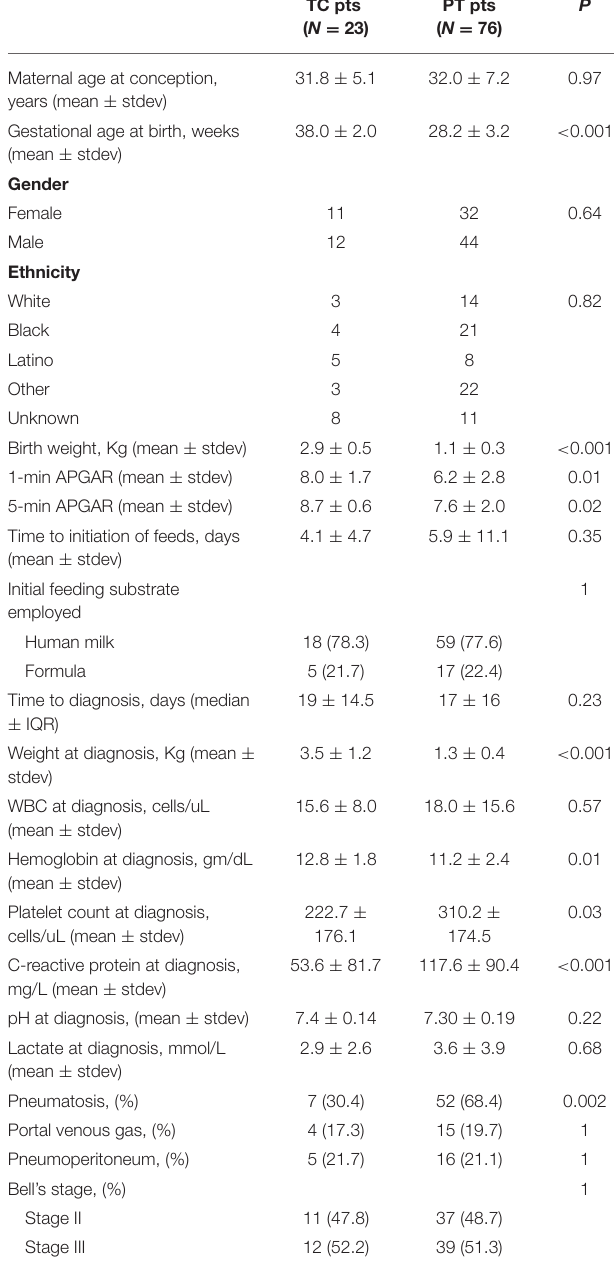
TABLE 1 | Patient